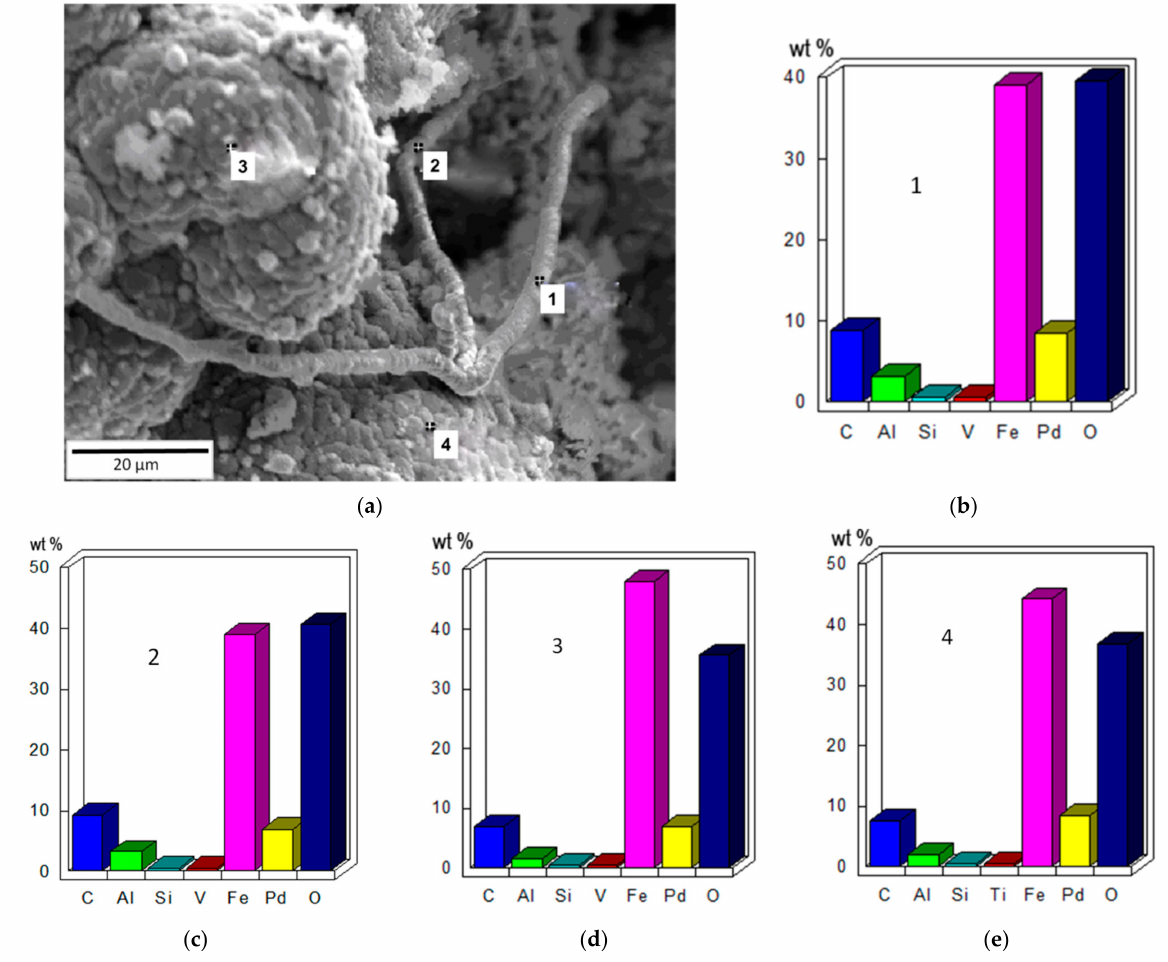
Figure 3. SEM image: goethite biomorphosis by wood and bacteria ( a ), energy-dispersive detector (EDS)microprobe data (wt.%) of biofilms ( b – e